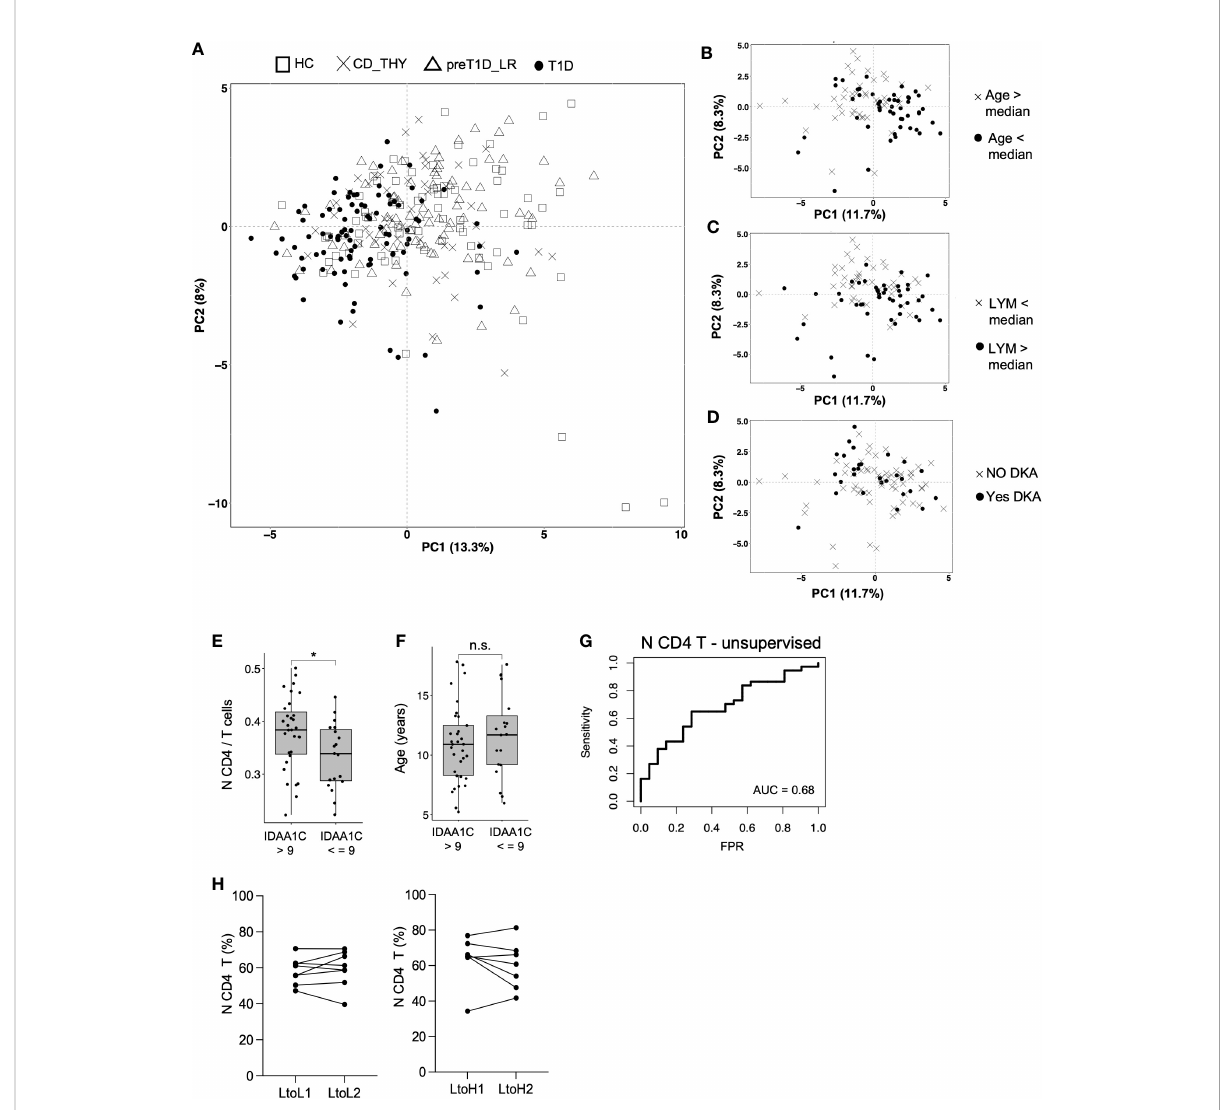
FIGURE 5 Frequency of N CD4 T cell at disease onset is associated with partial remission. Immunome-based principal component analysis performed on HC (n=73), CD_THY (n=47), preT1D-LR (n=82) and T1D (n=91) (A) ; segregation of the circulating immunome of newly diagnosed T1D patients (n=91) based on median age (B) , median peripheral lymphocyte count (C) and presence of DKA (D) ; comparison of the frequency of N CD4 T cell (E) and age (F) between newly diagnosed T1D patients with IDAA1C >9 (n=39) and IDAA1C ≤ 9 (n=21) at the 12-month follow-up visit; model for the prediction of partial remission based on the frequency N CD4 T cell at disease diagnosis (G) ; N CD4 T cell frequency in relatives who maintained a stable Stage 0 status or during the transition from Stage 0 (0-1 Aab) to a Stage ≥ 1 condition ( ≥ 2Aabs) (H) . LYM, lymphocytes; DKA, diabetic ketoacidosis; IDAA1c, insulin dose adjusted HbA1c; AUC, Area under the curve: N CD4 T cells: naïve CD4 T cells. Signi fi cant differences were determined by unpaired (4E, F) and paired (4H) Student ’ s t-test for pairwise comparisons (*p < 0.05, ns, not signi fi